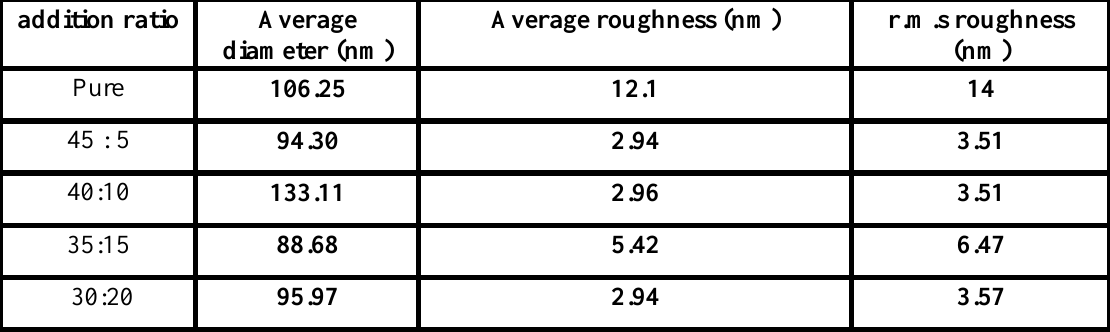
Table 2: Morphology parameters of SnO